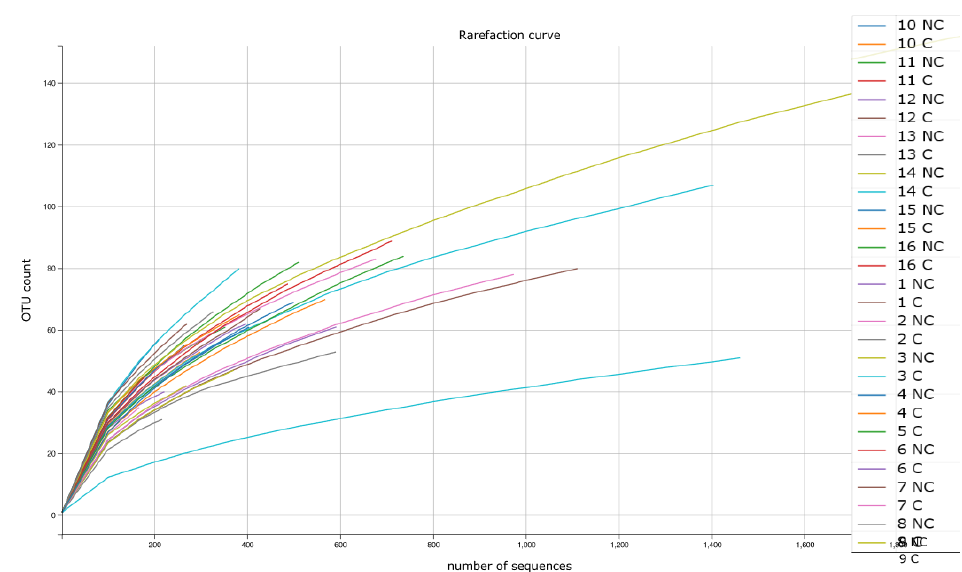
Figure A 2. Rarefaction curves for the observed OTUs in the C and NC Lublin Region soils at a genetic distance of 0.01.